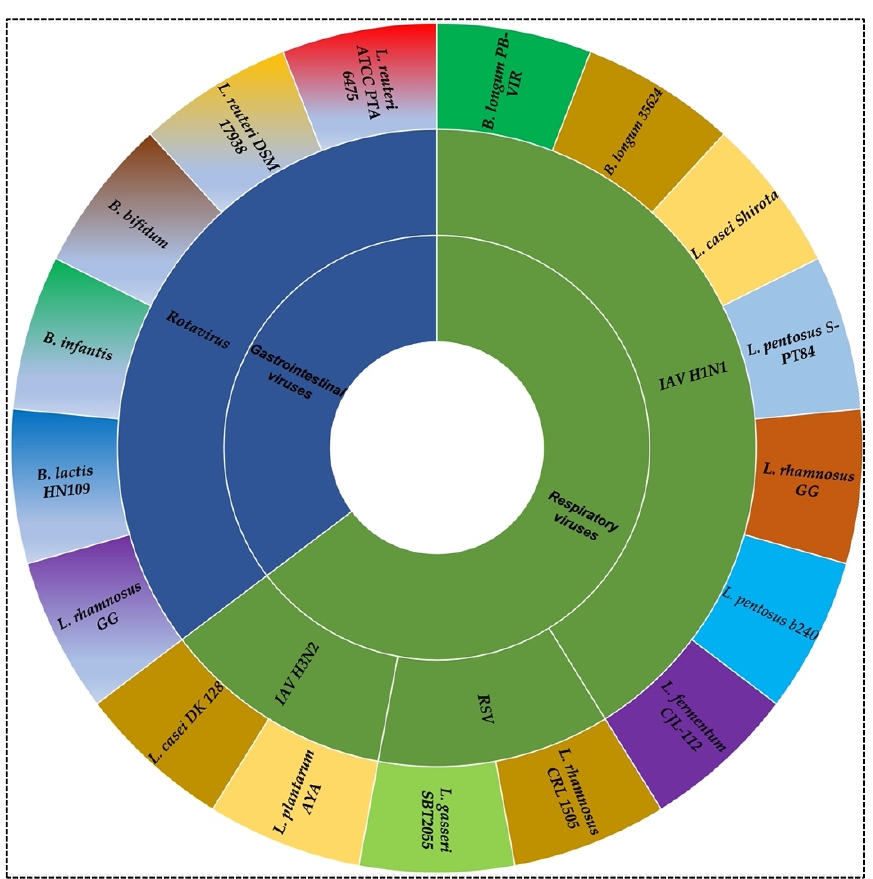
Figure 1. Probiotics strains against respiratory (influenza A virus H1N1, H3N2, and respiratory syncytial virus) and gastrointestinal viruses (rotavirus). The figure represents some examples of different strains of Lactobacillus and Bifidobacterium studied for the antiviral effects against viruses. More than 70% of the body’s immune cells are located in the GI tract, indicating a direct connection between the immune system and intestinal microflora, which provide some relationships with GI viruses [26]. Some studies have revealed the immunomodulation effect of Lactobacillus and Bifidobacterium against rotavirus (RV), one of the leading global causes of life-threatening diarrhea in children under the age of five [27,28]. RV alters the human gut microbiome by shifting the dominant phylum from Bacteroidetes to Firmicutes , decreasing bacterial diversity, and increasing opportunistic pathogens, such as the genera Shigella [29]. Both Lactobacillus reuteri strains ATCC PTA 6475 and DSM 17938 augmented mucosal RV-specific antibodies in infected neonatal mice and attenuated diarrhea symptoms [30]. The nutritional status of body mass index—normal weight, underweight, and overweight—may impact the response of probiotics on RV. Underweight mice had fewer RV-specific antibodies than the other two groups. In another study, the combination of Lactobacillus rhamnosus GG with specific bovine colostrum-derived immunoglobulins